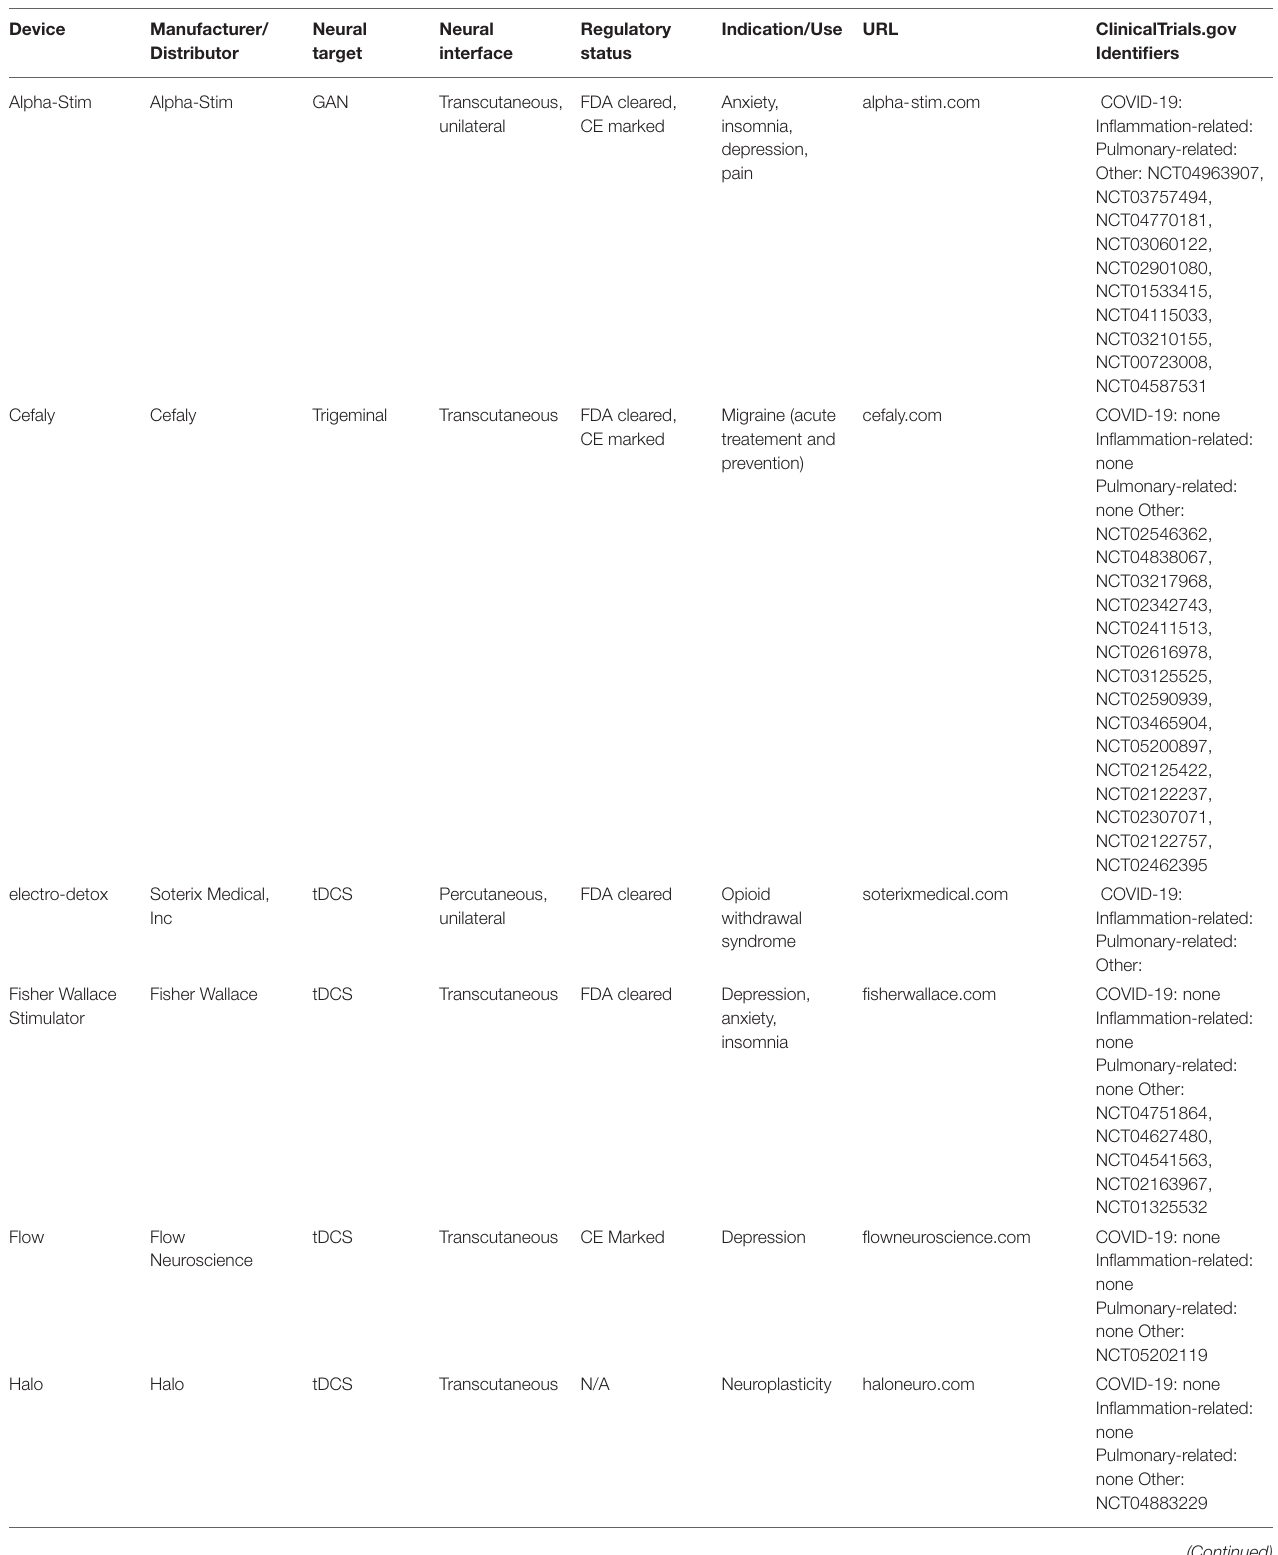
TABLE 3 | Examples of commercially available devices that are currently being tested in trials unrelated to COVID-19, but which have neural mechanisms of action that could be related to the pathological sequelae of COVID-19.